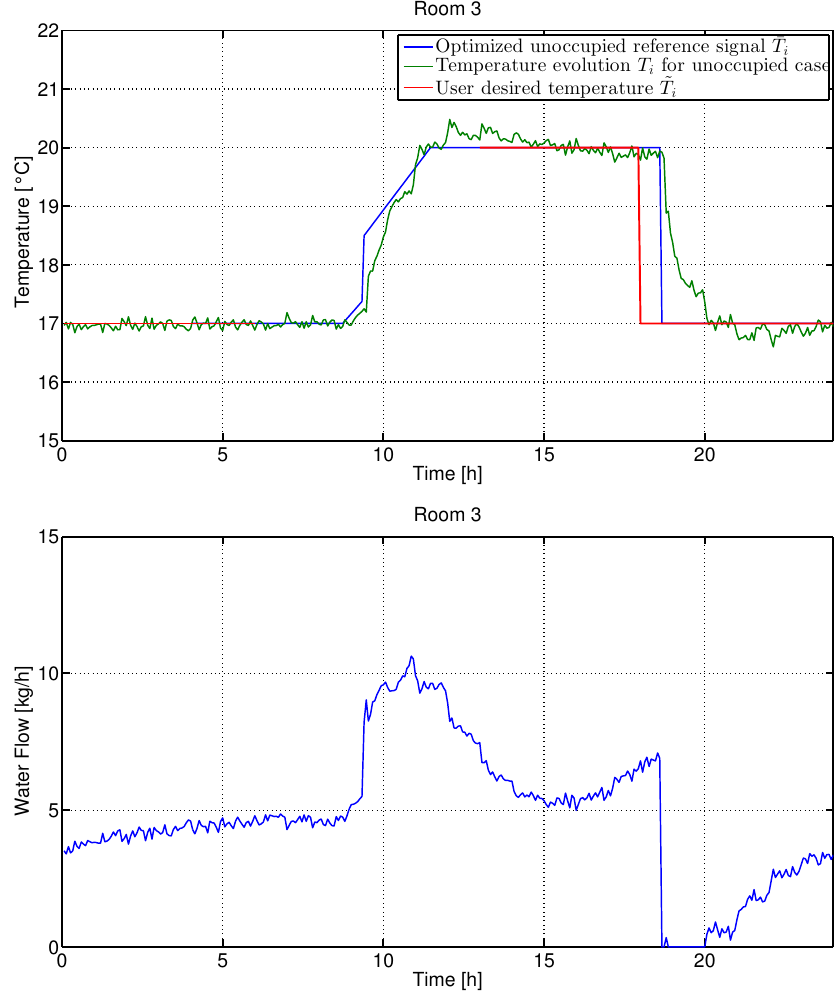
Figure 13. One day simulation (TRNSYS model), 5 December, for room 3 for the case of unoccupied rooms, case of radiators and ramp set-point signals.